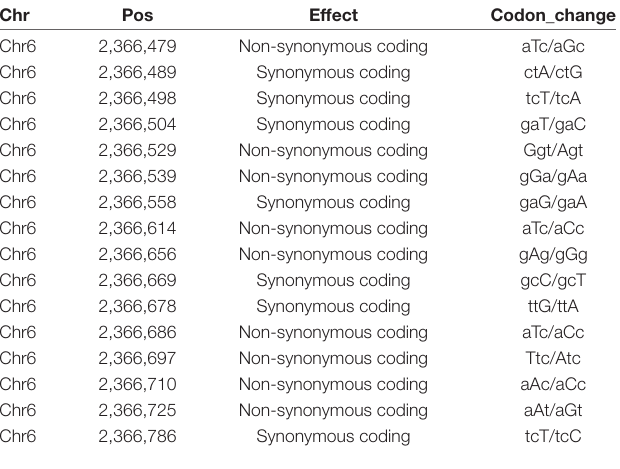
TABLE 2 | Chromosomal positions and the codons of 16